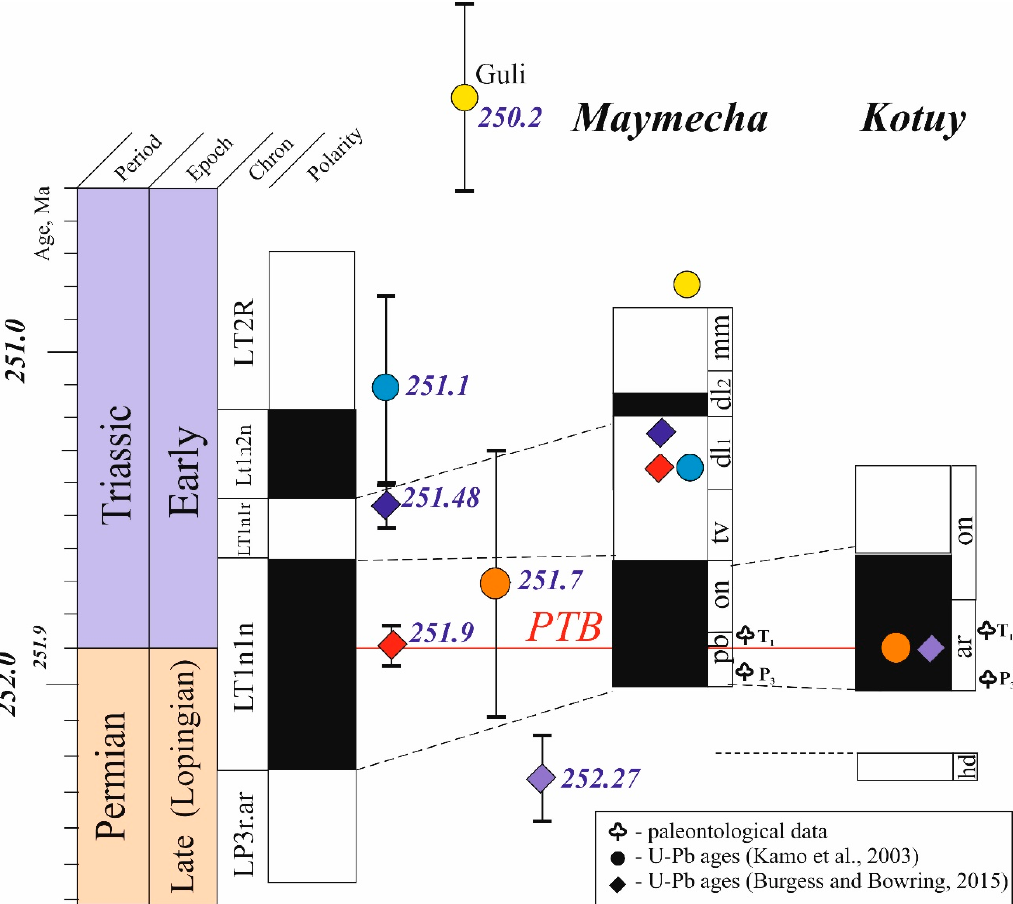
Figure 8. Magnetic stratigraphy and correlation of the Maymecha and Kotuy volcanic sections.